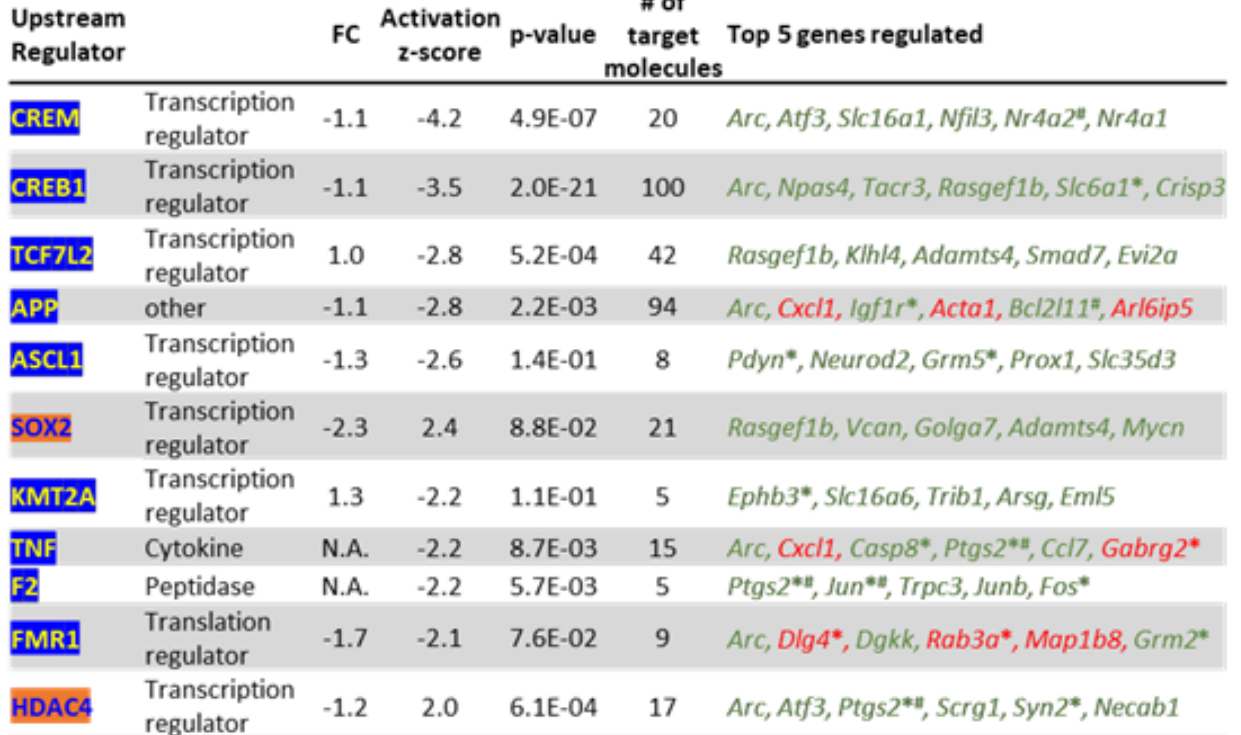
Figure 17. Upstream regulators associated with differential gene expression observed upon knockdown of Arc. Activation z-score indicates the predicted activity of upstream regulators by IPA analysis. Upstream regulators that were predicted to be inhibited are highlighted in blue while those activated are highlighted in orange. Regulated genes were highlighted in green (downregulated) and red